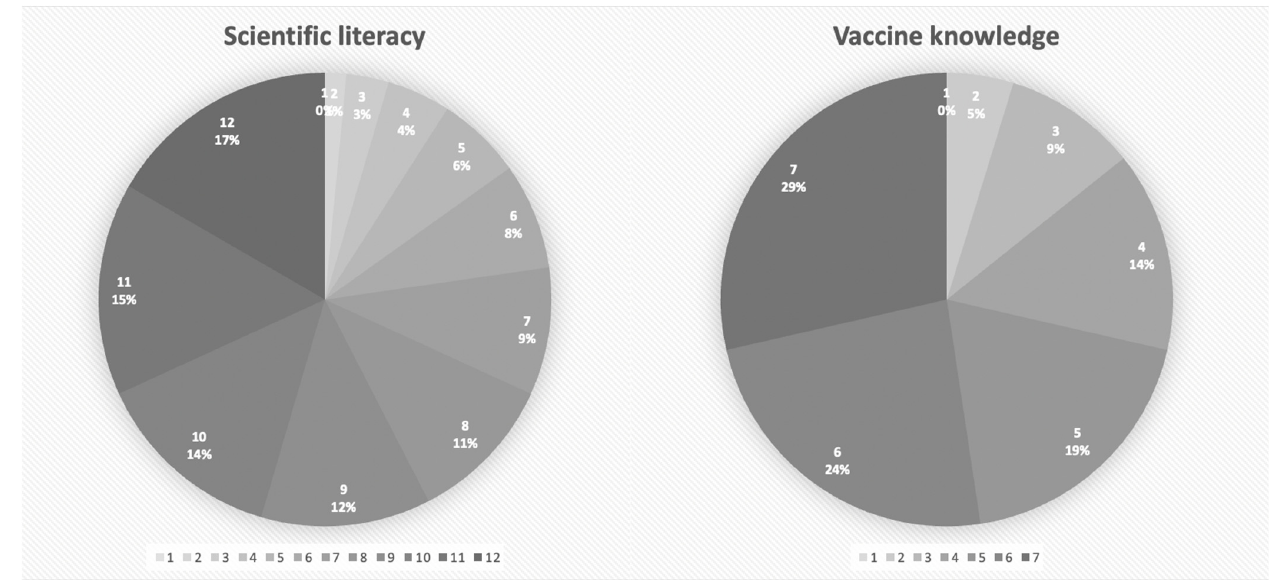
Figure 1. Level of scientific literacy and vaccine knowledge of participants ( n = 2038).